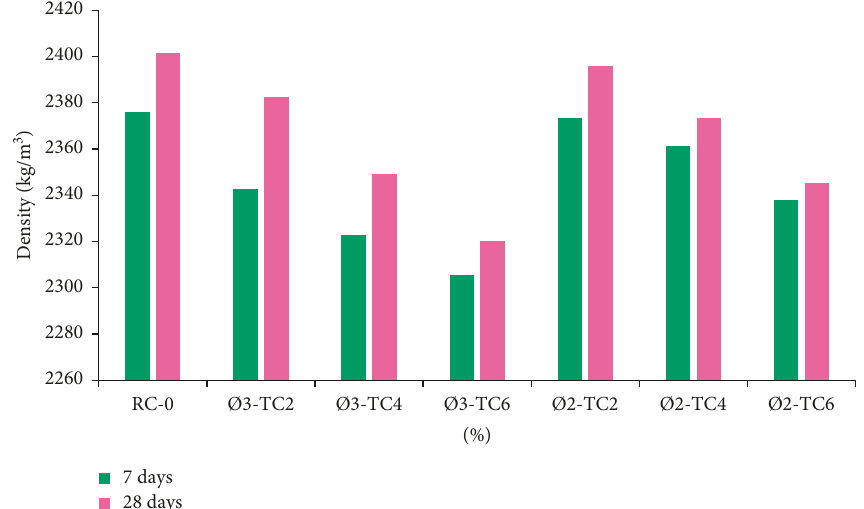
Figure 4: Bulk density of the translucent concrete at 7 days and 28 days of age.